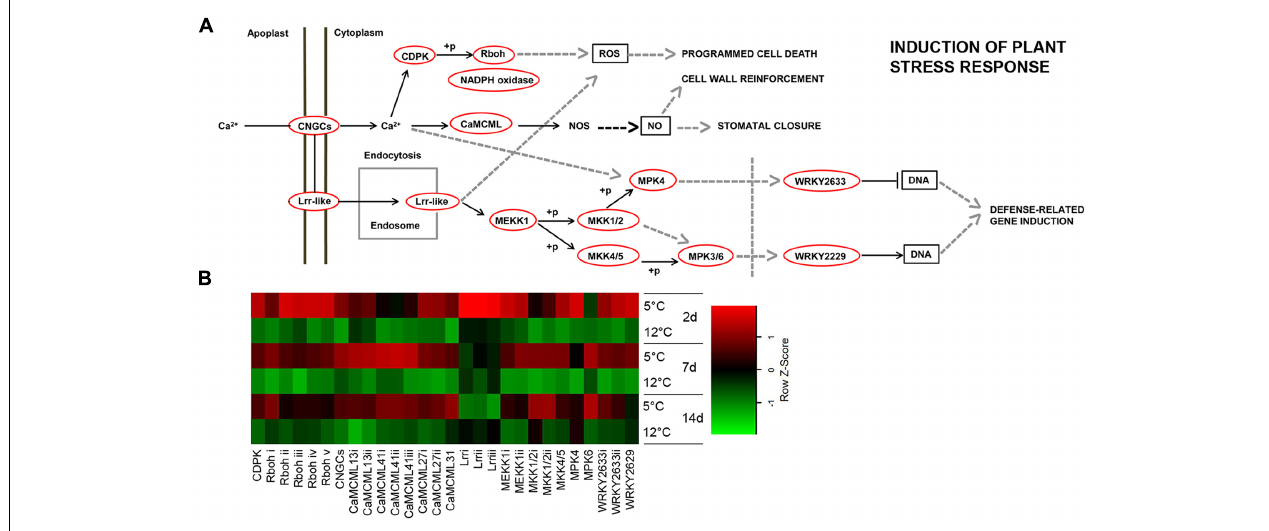
FIGURE 4 | Plant stress-response-signaling pathway induced in response to cold storage. (A) Plant induction of stress-response-signaling pathway based on the KEGG pathway mapper. Genes that are circled in red are significantly upregulated during cold storage at 5 ◦ C. (B) Expression heat map of genes related to induction of the plant stress response at two different storage temperatures (5 and 12 ◦ C) at different sampling times (2, 7, and 14 days). Z -scores represent rescaled log fold change values. Abbreviations, transcripts identification and expression profile are described in Supplementary Table S2